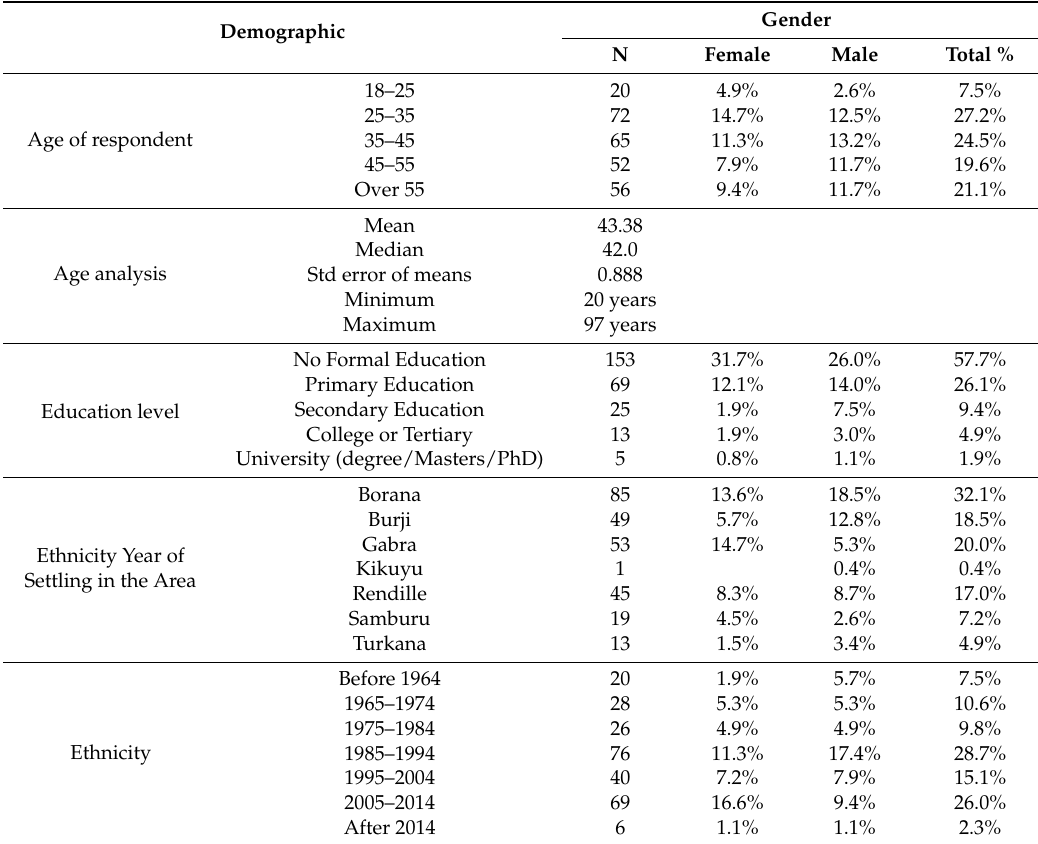
Table A1. Demographics of the respondents ( n =